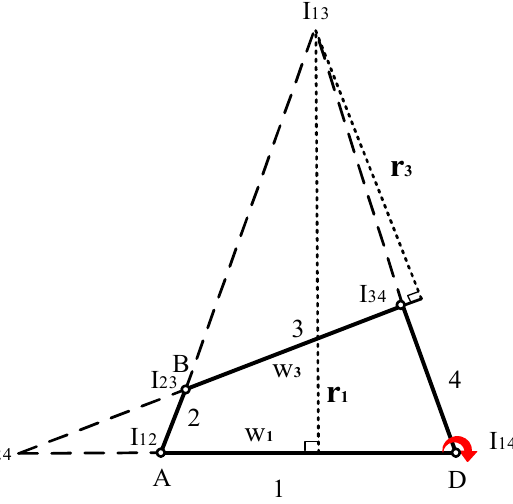
Figure 1. Planar four-bar linkage with instant centers.